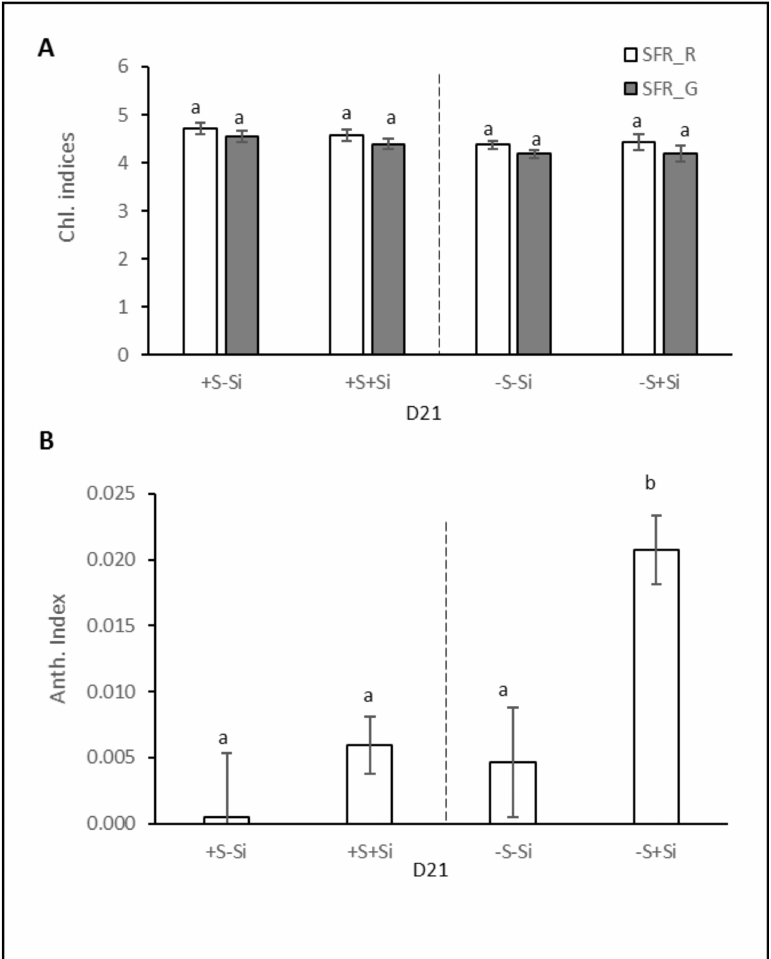
Figure 2. Chlorophyll (Chl., A ) and anthocyanin (Anth., B ) indices measured with an optical sensor (Multiplex) in shoots of Brassica napus L. cultivated in hydroponic conditions for 21 days (D21) with (+S; 500 µ M) or without sulfur (–S; 0 µ M) concentrations and with (+Si; 1.7 mM) or without silicon (-Si) supply. Data are means ± SE (n = 4). Different lowercase letters indicate significant difference in the indices ( p <